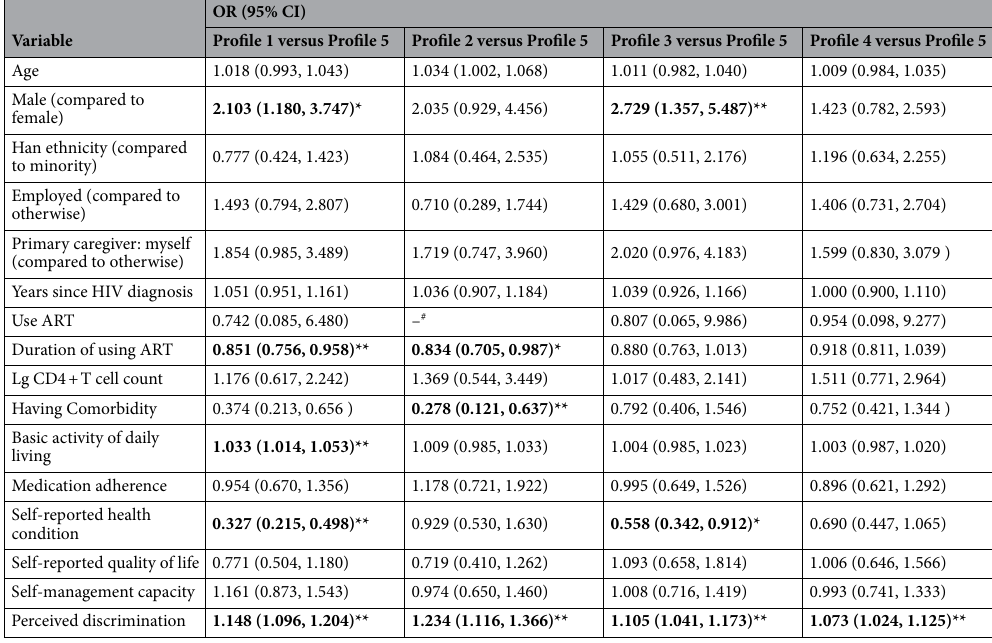
Table 3. Multnomial logistic regression analysis of five profiles. Significant values are in [bold]. Model fitness: Nagelkerke R 2 = 0.230, χ 2 = 522.403, P < 0.0001. * P < 0.05, ** P < 0.01, # insufficient statistical power in